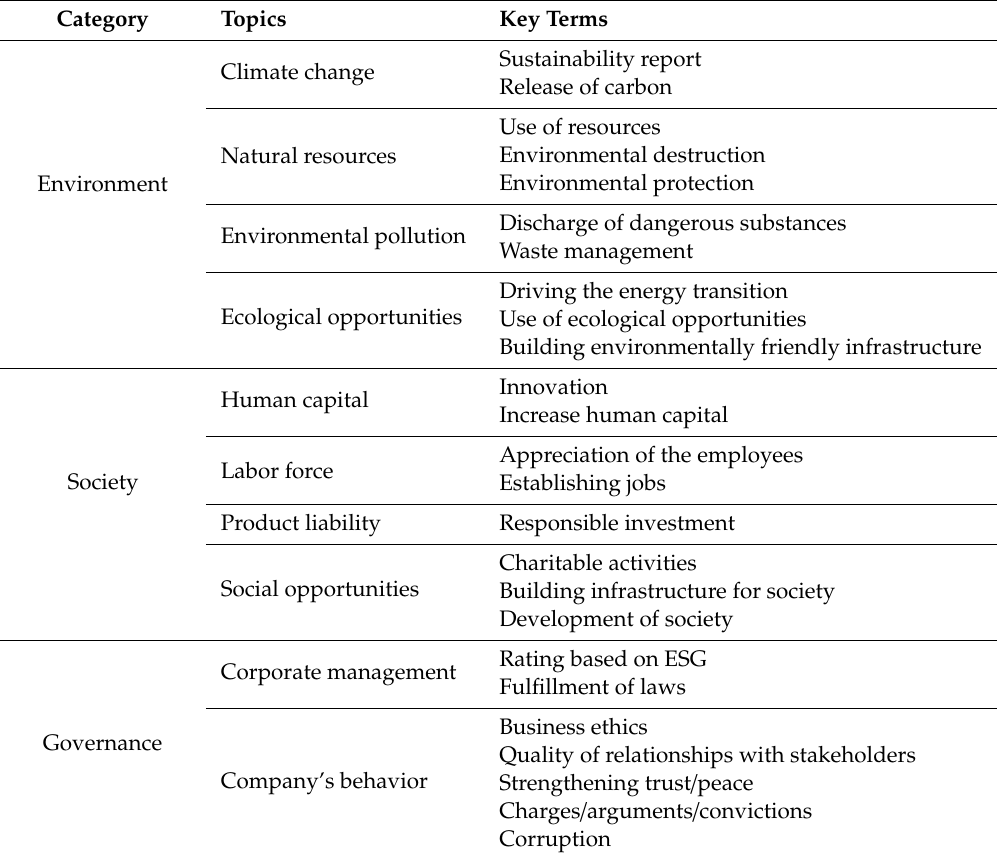
Table 6. Catalog of criteria for CSR-relevant